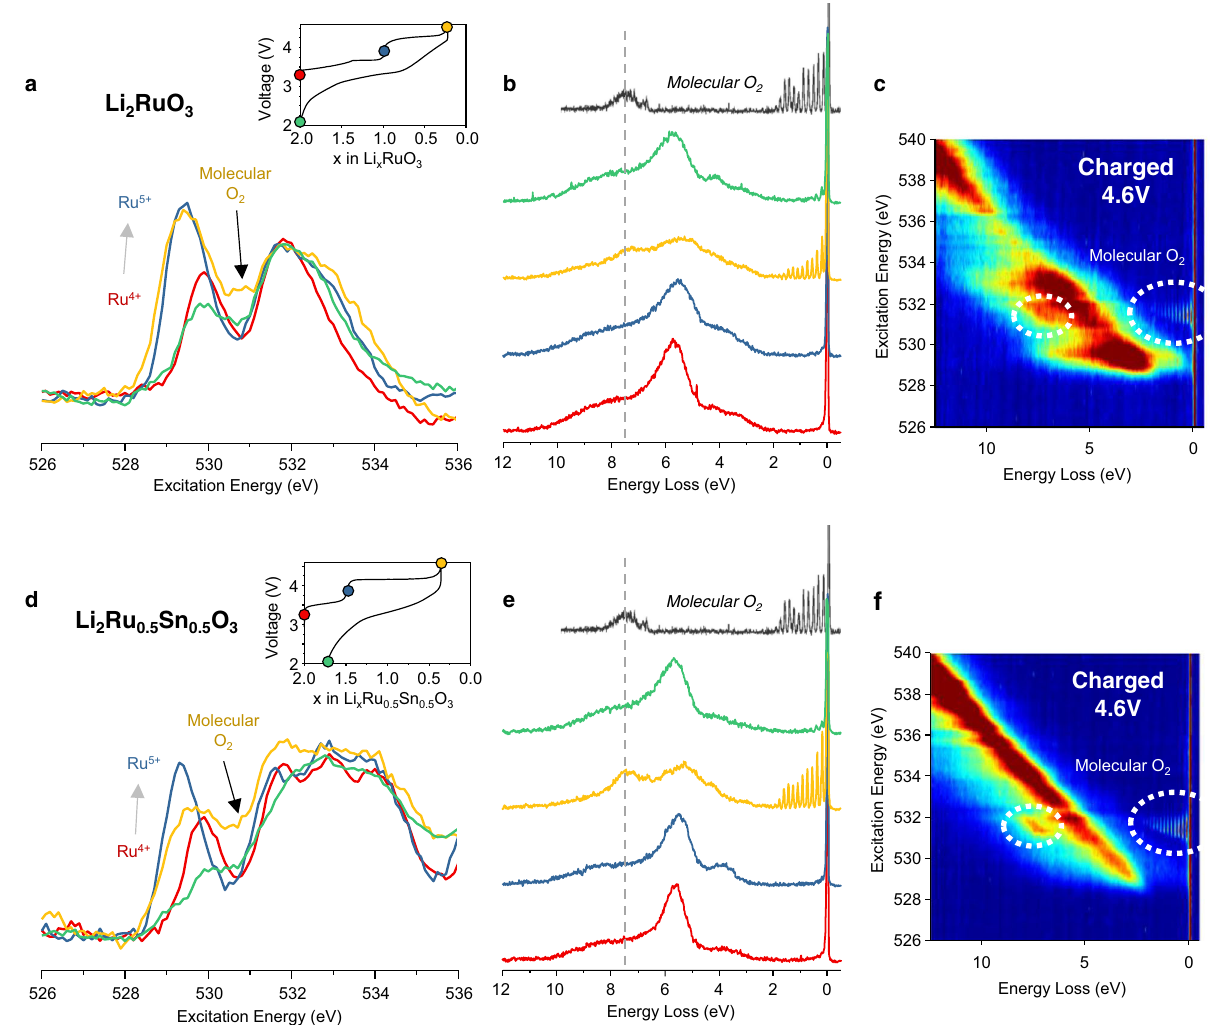
Fig. 2 O XAS and RIXS spectroscopy for Li-rich ruthenates. a , d O K-edge XAS spectra collected in bulk sensitive partial fl uorescence yield (PFY) mode. Inset fi gure — load curve showing with coloured dots where on the load curve the spectra were collected. b , e high resolution RIXS line scans at an excitation energy of 531 eV. Spectrum of molecular O 2 gas shown for reference in black (reproduced from ref. 35 ). The RIXS line scans reveal the formation of molecular O 2 which is reduced to O 2 − on discharge. c , f High resolution RIXS maps of the O K-edge pre-edge for cathodes charged to the end of the high voltage plateau. Across the plateau there is an increase in area at 531 eV for both Li 2 RuO 3 and Li 2 Ru 0.5 Sn 0.5 O 3 . The RIXS maps show that there are no other O – O